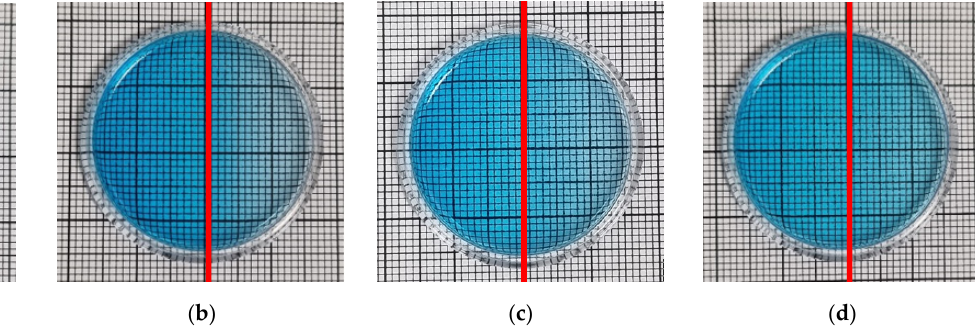
Figure 8. Photographs of TBO ‒ Pluronic F ‒ 127 over time after irradiation with 1 J/cm 2 UVB to half of the container: immediately ( a ), 1 day ( b ), 5 days ( c ) and 8 days ( d ) after irradiation. Red lines denote the position of a border between irradiated and non ‐ irradiated parts of the dosimeter.